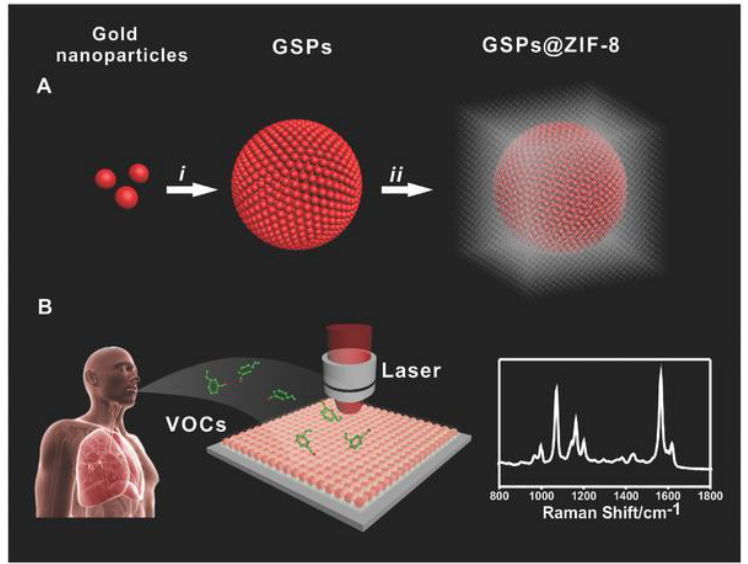
Figure 6. ( A ) Diagrammatic sketch of synthesizing GSP@ZIF-8 core – shell structure: (i) AuNPs assembled into GSPs, (ii) ZIF-8 shell coated on GSP surface; ( B ) volatile organic compound (VOC) detection via SERS spectroscopy. Reproduced with permission from Ref. [104] Copyright 2017, Wiley.